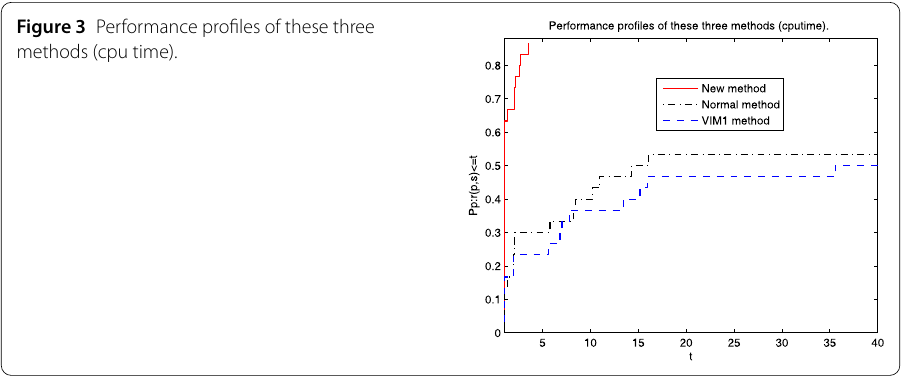
Figure 3 Performance profiles of these three methods (cpu